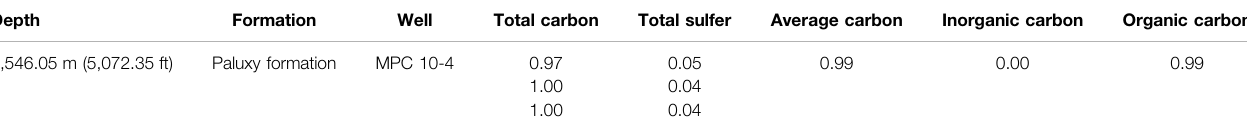
TABLE 2 | Carbon analysis results from the MPC 10-4 well, Kemper County energy facility.